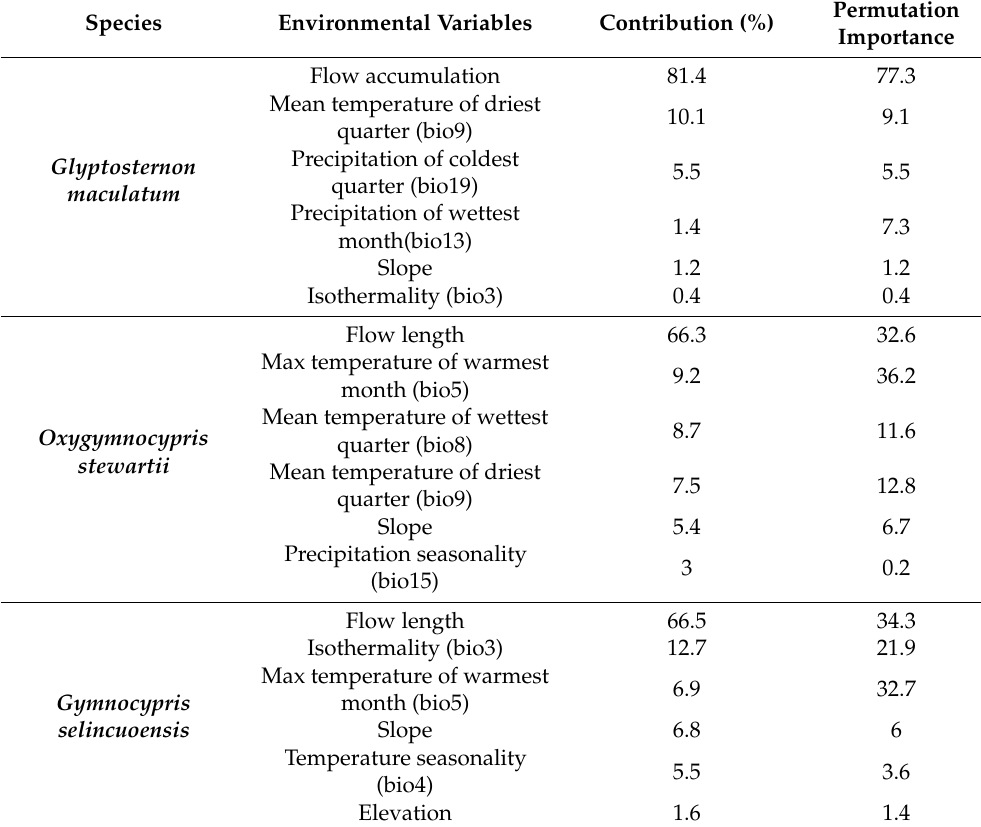
Table 1. Environmental variables used in MaxEnt with contribution and permutation